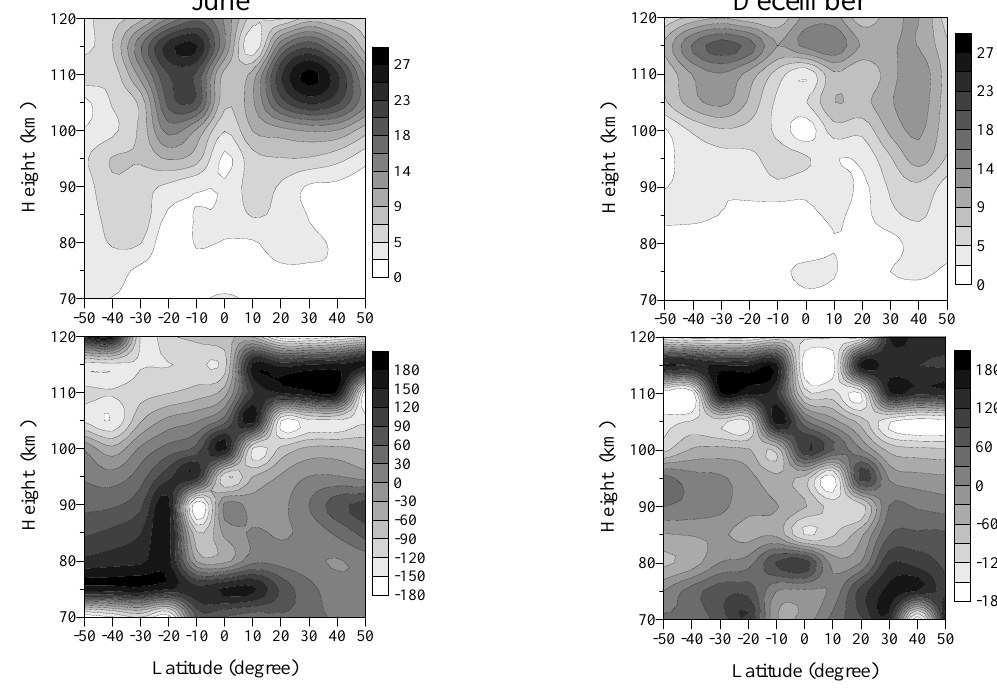
Figure 10a Fig. 10a. Average (2002–2007) altitude-latitude cross-sections of the tidal amplitudes (upper row of plots) and phases (bottom row of plots) for June (left column of plots) and December (right column of plots).